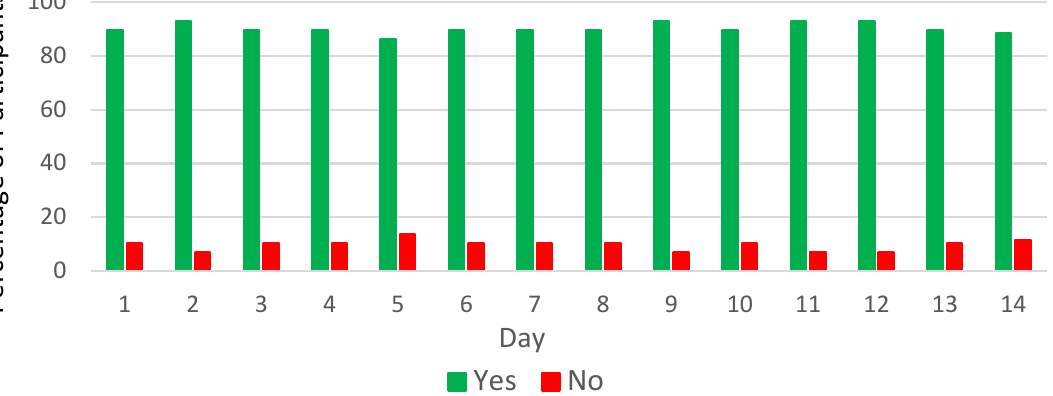
Scheme 2. Results show the percentage of child participants’ (aged 5–12) responses to the question: If this was medicine and you were sick, would you be willing to take this